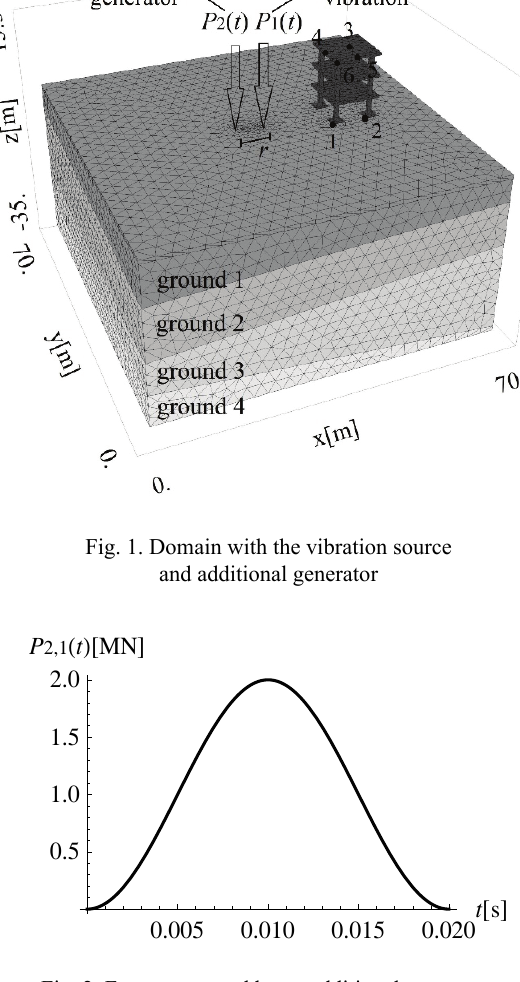
Fig. 2. Force generated by an additional generator, the first impact, haversine function A haversine load of amplitude 2 MN and dura- tion d = 0.02 s is applied to the ground surface, as in Figs. 1 and 2 (Mabsout and Tassoulas [15]). The period of a hammer blow is T = 1